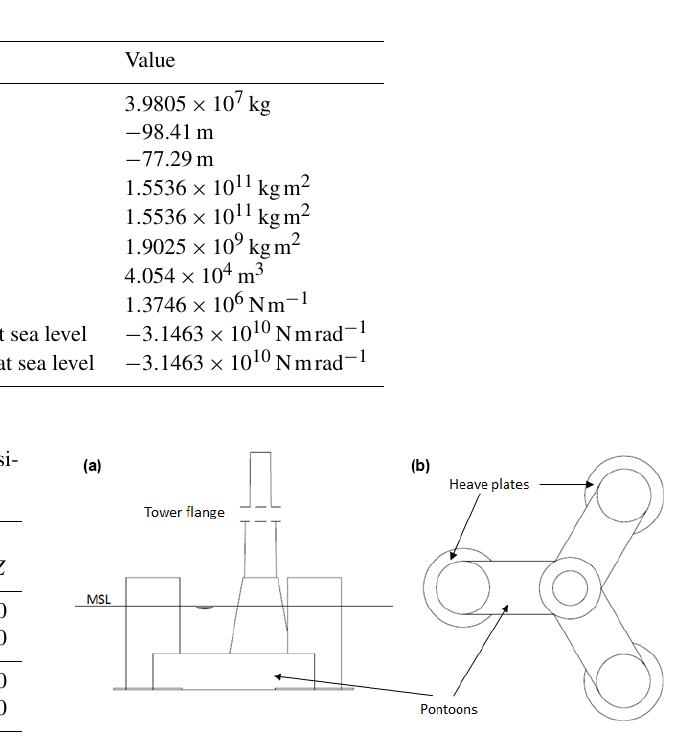
Figure 2. Activefloat geometry (side view in a and top view in b